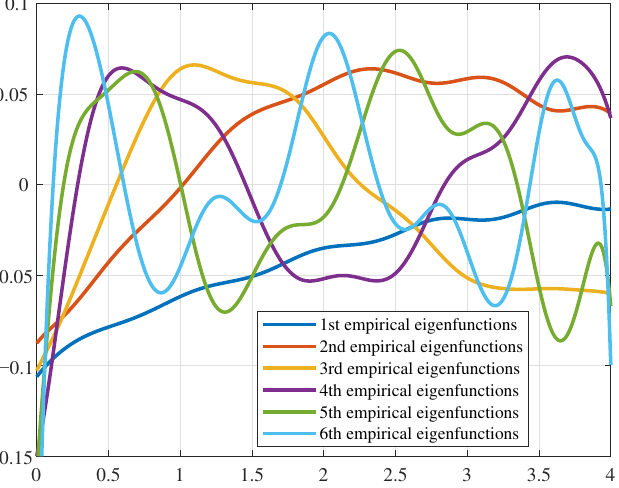
Figure 3. The first six empirical eigenfunctions based on the microwave heating Debye media. Substituting φ S ( x ) into (38), the reduced-order model can be obtained. Based on the